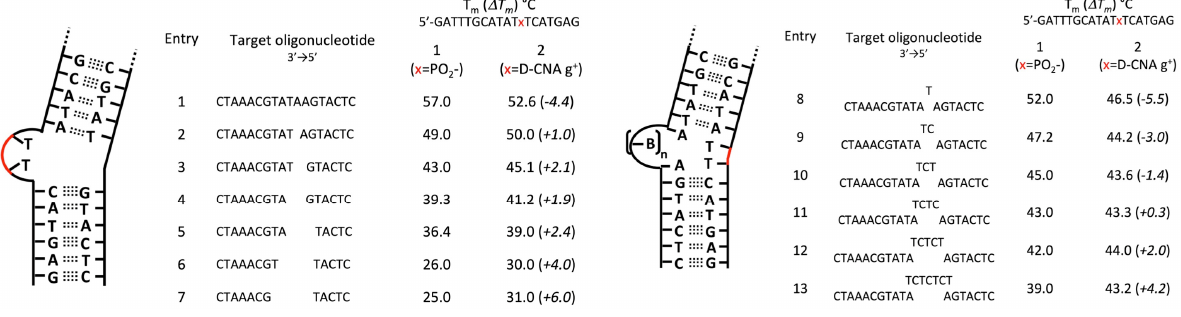
Figure 10. α , β -D-CNA (g + , t) within bulge structures. ( Left ): within the bulged moiety. ( Right ): opposite to the bulged moiety.